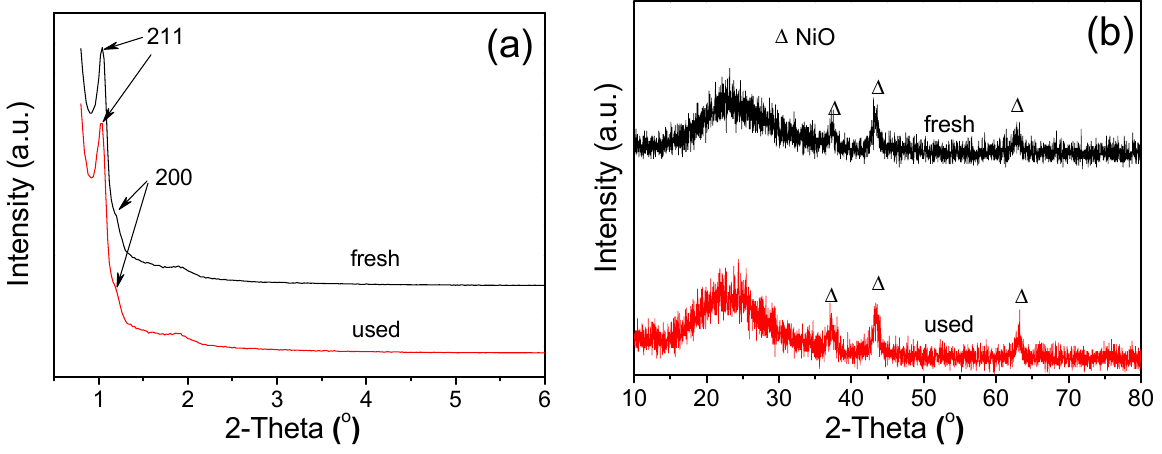
Figure 8. ( a ) Low-angle XRD patterns of fresh and used 10% NiO/KIT-6 catalyst; ( b ) wide-angle XRD patterns of fresh and used 10% NiO/KIT-6 catalyst ( ∆ NiO: NiO diffraction peak).